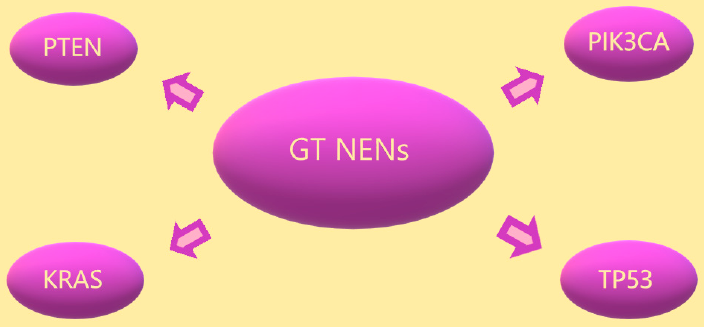
Figure 2. Gynaecological tract NENs and their most common mutations.